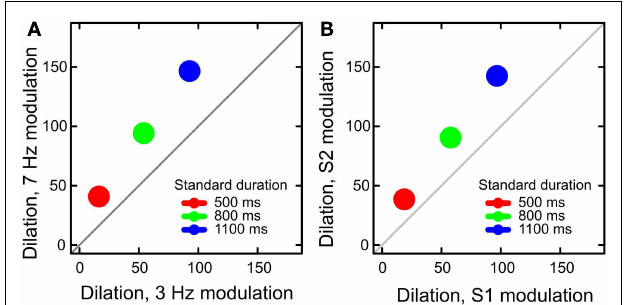
FIGURE 6 | Results of numerical simulation. (A) The amount of dilation predicted by the model is increased by stimulus modulation and it grows with stimulus duration. (B) Dilation was larger when the second stimulus (S2) was modulated than when S1 was modulated.This effect increased with stimulus